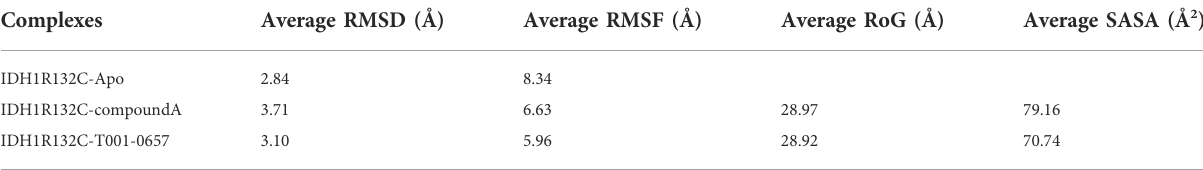
TABLE 3 The average root-mean-square deviation, root-mean-square fl uctuation, radius of gyration, and solvent-accessible surface area of the IDH1-R132C-apo, IDH1-R132C-compound A and T001-0657 complexes.